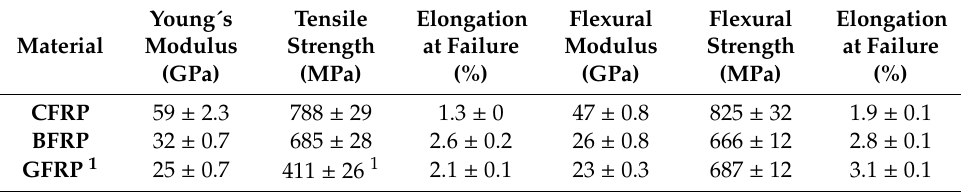
Table A2. Mechanical properties of carbon, glass and basalt fiber reinforced PBF-a based polymers.